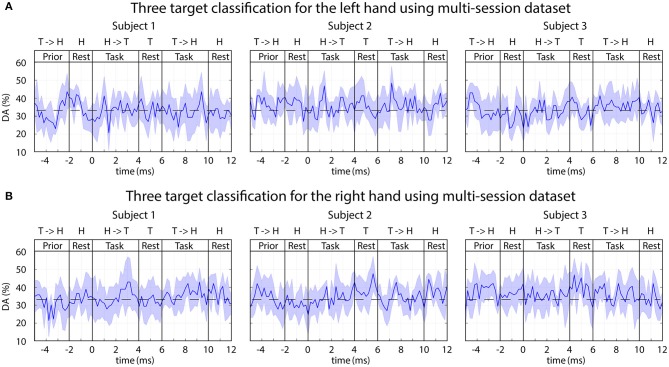
FBCSP: time-varying DA during imagined movements toward three different targets. The 3-class DA presented in this figure was calculated from a multi-session dataset based on the imagined movement of the left (A) and right (B) hands using sub-blocks without displaying movement on the screen (auditory stimulus only). The horizontal dashed line indicates the chance level (33% for 3-class classification).